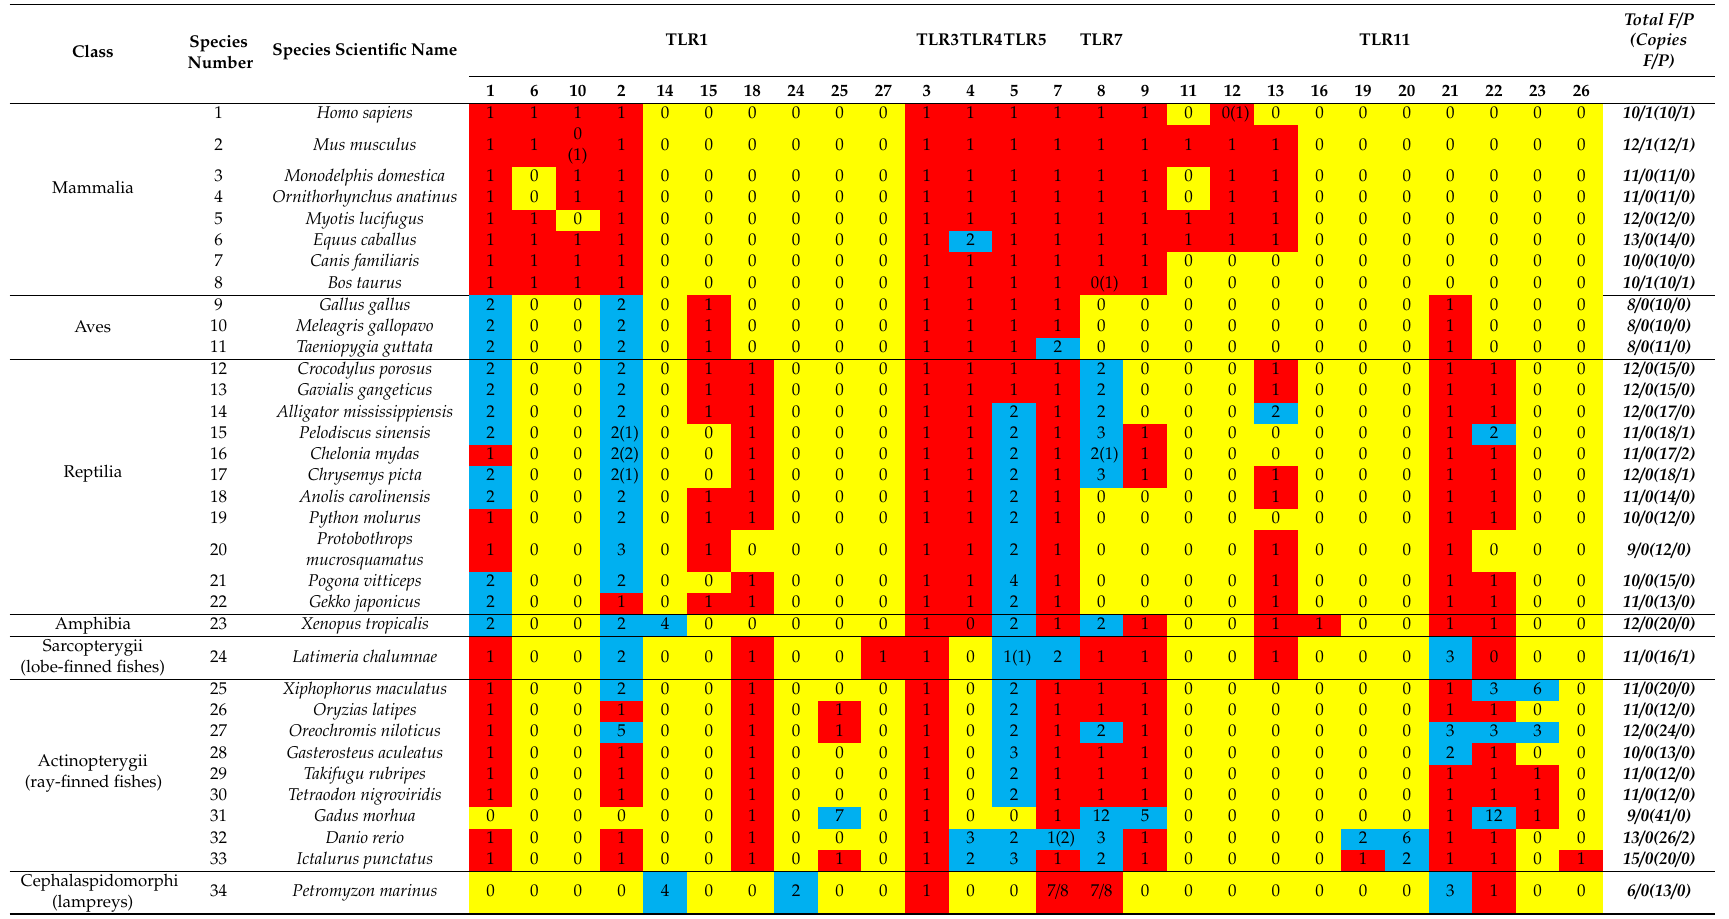
Table 1. The TLR supergene family repertoire, showing gene gain and loss in di ff erent vertebrate